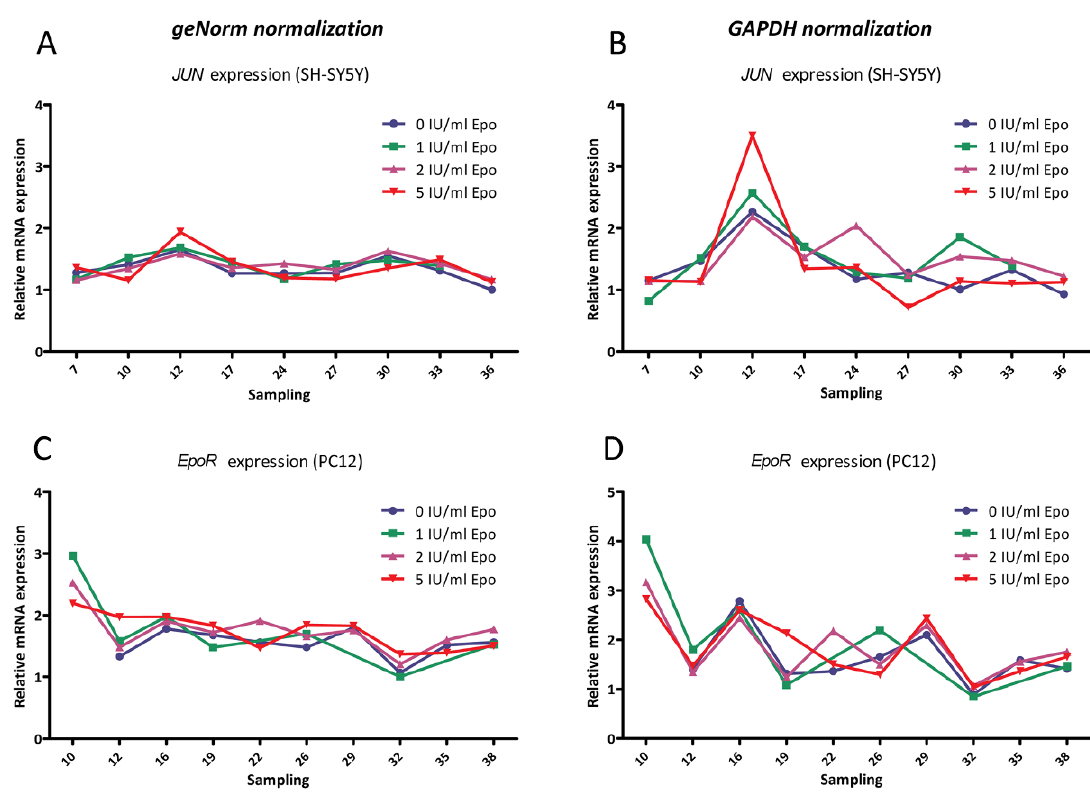
Figure 3. Normalization with geNorm and GAPDH